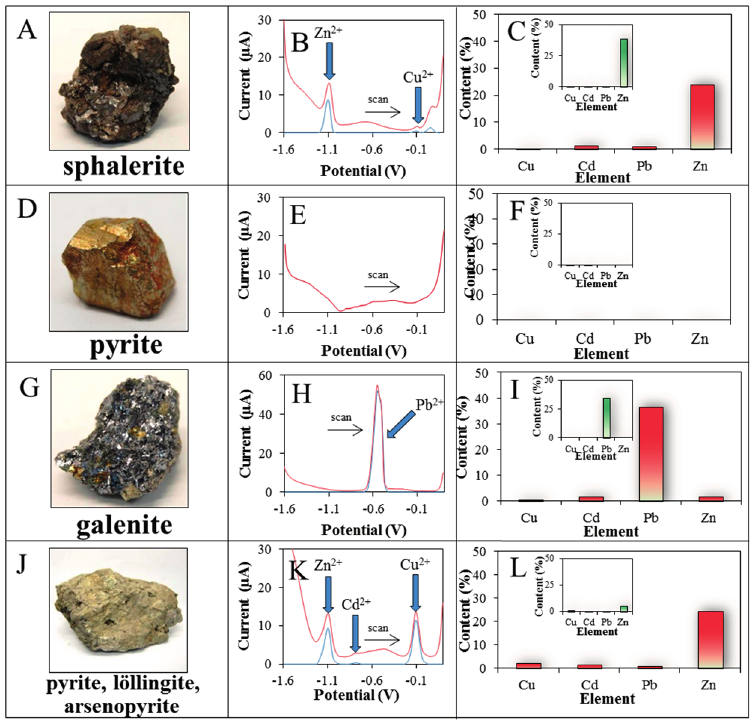
Figure 3. ( A ) Photo, original (red) and ( B ) baselined voltammogram (blue); ( C ) the element content in the rock calculated by neuronal network from voltammograms and element content measured using XRF (inserts) of rocks containing ( D – F ) sphalerite and pyrite; ( G – I ) galenite; and ( J – L ) arsenopyrite, pyrite, and